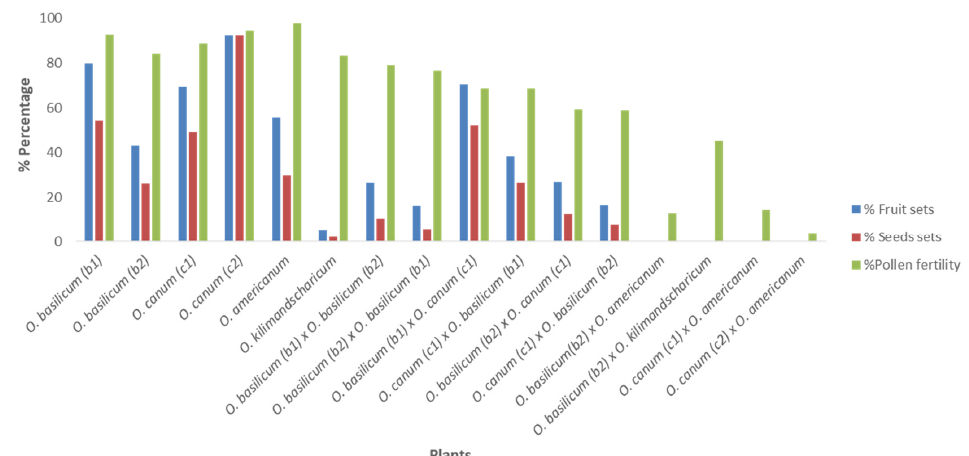
Figure 1. Percentage fruit sets, seed sets and pollen fertility of Ocimum spp. and their F 1